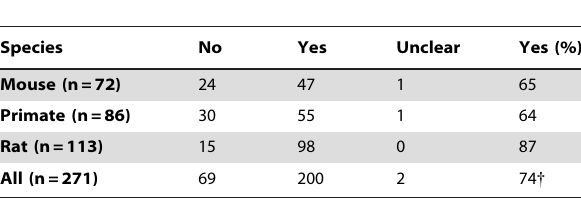
Table 7. Number of studies reporting the sex of the animals.